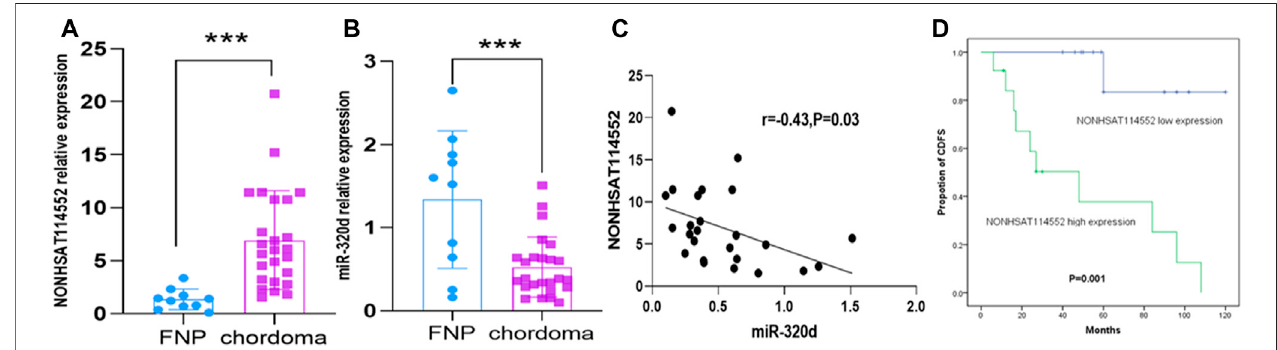
FIGURE1| OverexpressionofNONHSAT114552inchordomaanditsrelationtopatients ’ prognosis (A,B) qRT-PCRshowedthatlncRNANONHSAT114552was overexpressed and miR-320d was reduced in chordoma (C) . Pearson correlation test showed negative relationship between NONHSAT114552 and miR-320d. (D) . CDFS on the basis of NONHSAT114552 expression in